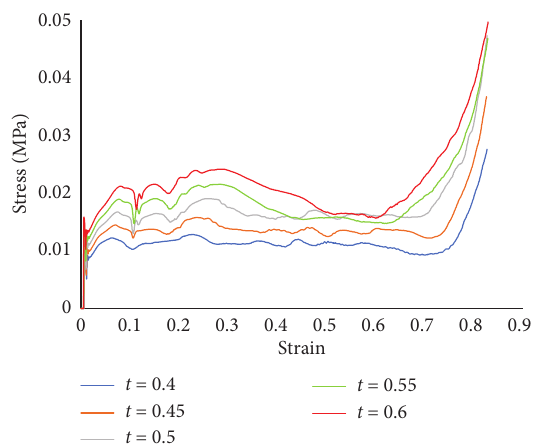
Figure 9: Stress-strain curves of honeycomb aluminum under different cell wall thicknesses.